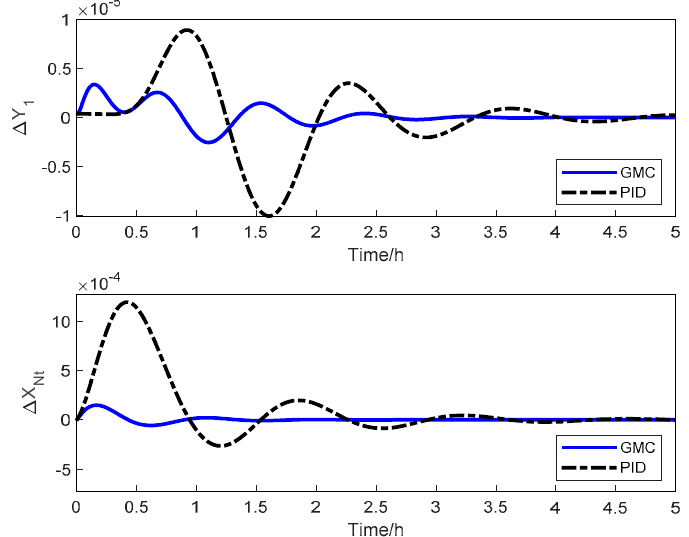
Figure 17. Response curve of controlled variable when the feed flow rate F +20% in Case 2.